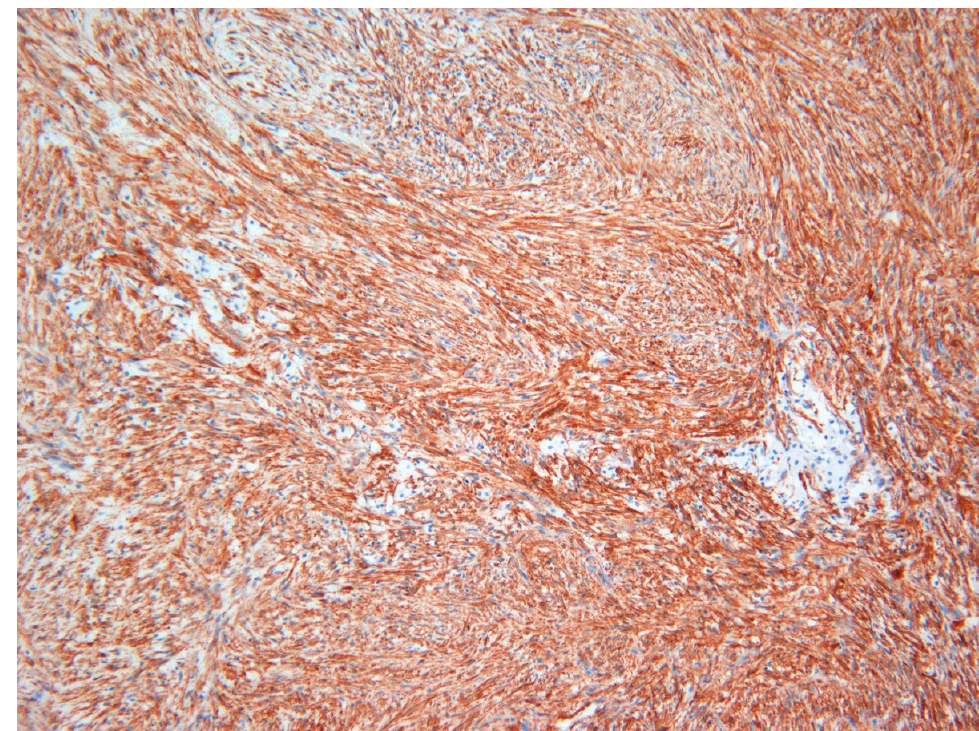
Figure 3. Immunohistochemical investigations with smooth muscle actin (SMA) revealed strong positivity in tumor cells in Case 1 (×20). Table 1. Immunohistochemical investigations performed for Cases